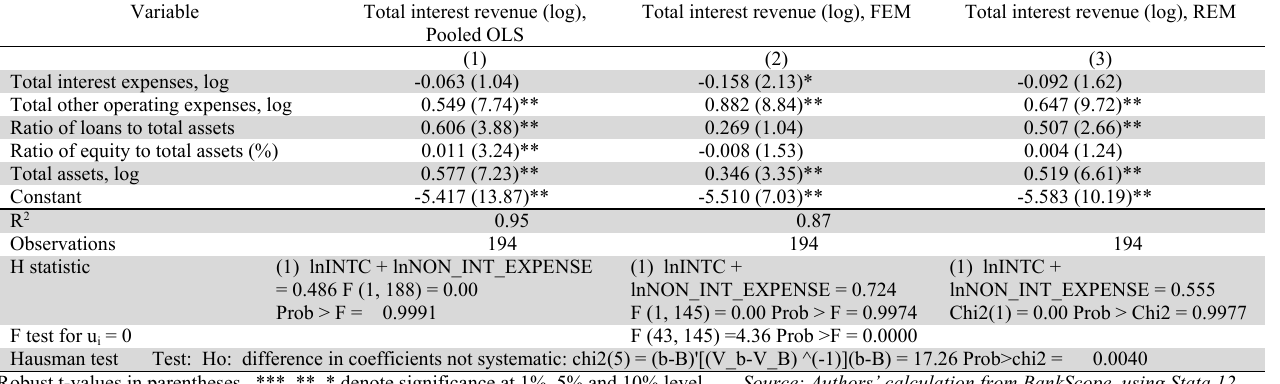
Competition model of Vietnamese commercial banks,